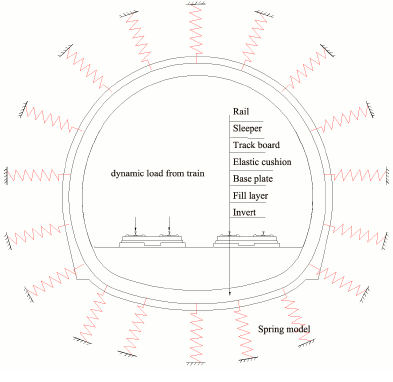
Figure 4. Boundary condition.